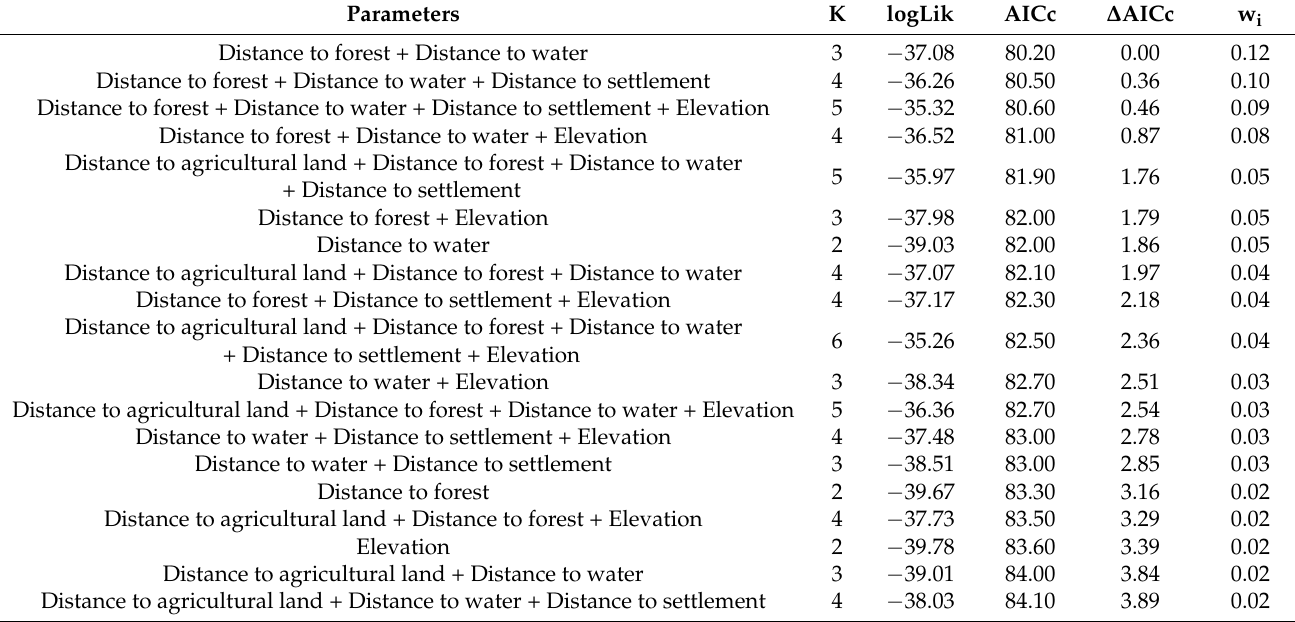
Table 1. Outputs from generalized linear models to identify factors related to the probability of presence of Egyptian vultures, Madi River corridor, Nepal. Egyptian vulture (presence) used as response variable; elevation (m); distance to forest (m), distance to agricultural land (m), distance to human settlement (m), distance to water (m) are predictive variables. K is the number of parameters, ∆ AICc is the difference between the AICc value of the best-supported model and successive models, and wi is the Akaike model weight. Only models with ∆ AICc < 4 are reported. Parameters K